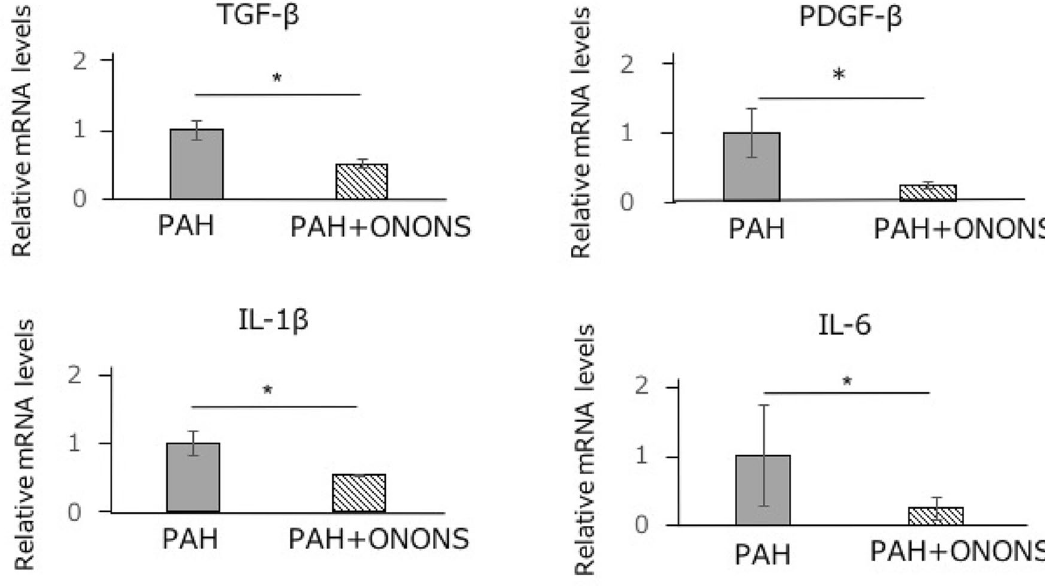
Figure 7. Effect of ONO1301 on the production of inflammatory markers. ONO1301 nanosphere (ONONS) treatment significantly suppressed expression of TGF-β, PDGF-β, IL-1β, and IL-6. * P < 0.05. n = 5. n.s. not significant.